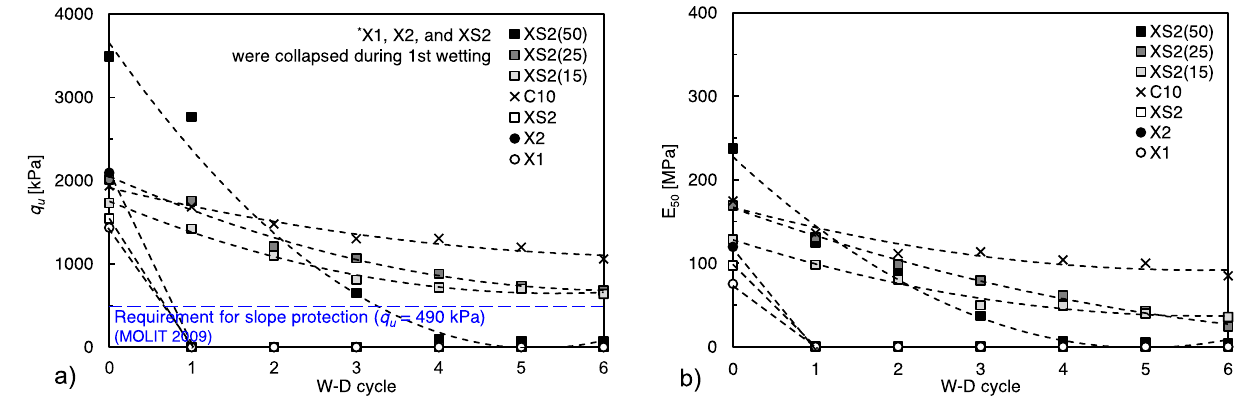
Figure 8. Cyclic W–D durability test result ( a ) q u , ( b ) E 50 .